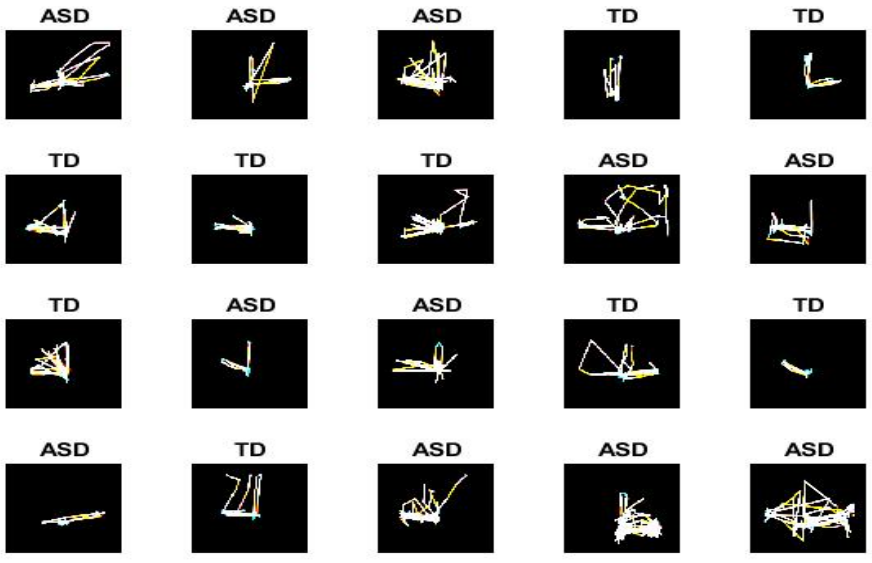
Figure 3. ASD dataset after segmentation and selection of